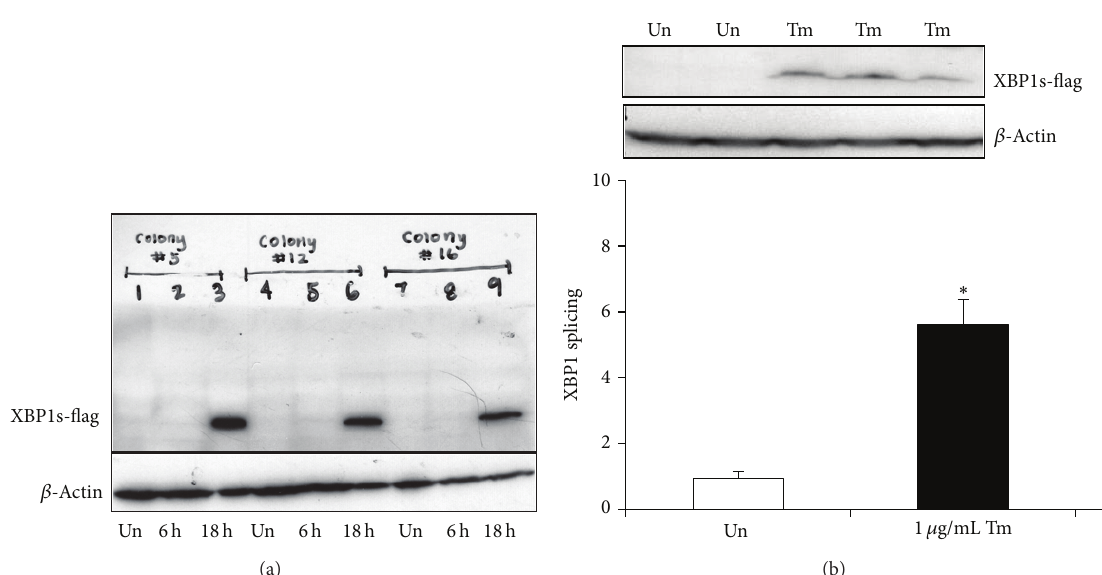
Figure 2: Detection of XBP1 splicing in human proximal tubule-2 cells using XBP1sVenus reporter. (a) XBP1sVenus was placed in a hygromycin B selectable cassette and transfected into HK-2 cells. Cells were then selected for stable incorporation of XBP1sVenus with 0.5 mg/mL hygromycin B. Clones were screened with 1 𝜇 g/mL tunicamycin (Tm) for 6 or 18 hours. Clones 3, 12, and 16 were found to give robust responses when probed with the flag-tag antibody and produced green fluorescence. (b) Clone 12 from the stably transfected XBP1s HK-2 reported cell line was grown up and untreated (Un) or treated with 1 𝜇 g/mL tunicamycin (Tm). The expression of the flag-tag shows IRE1 activation in the reporter cell